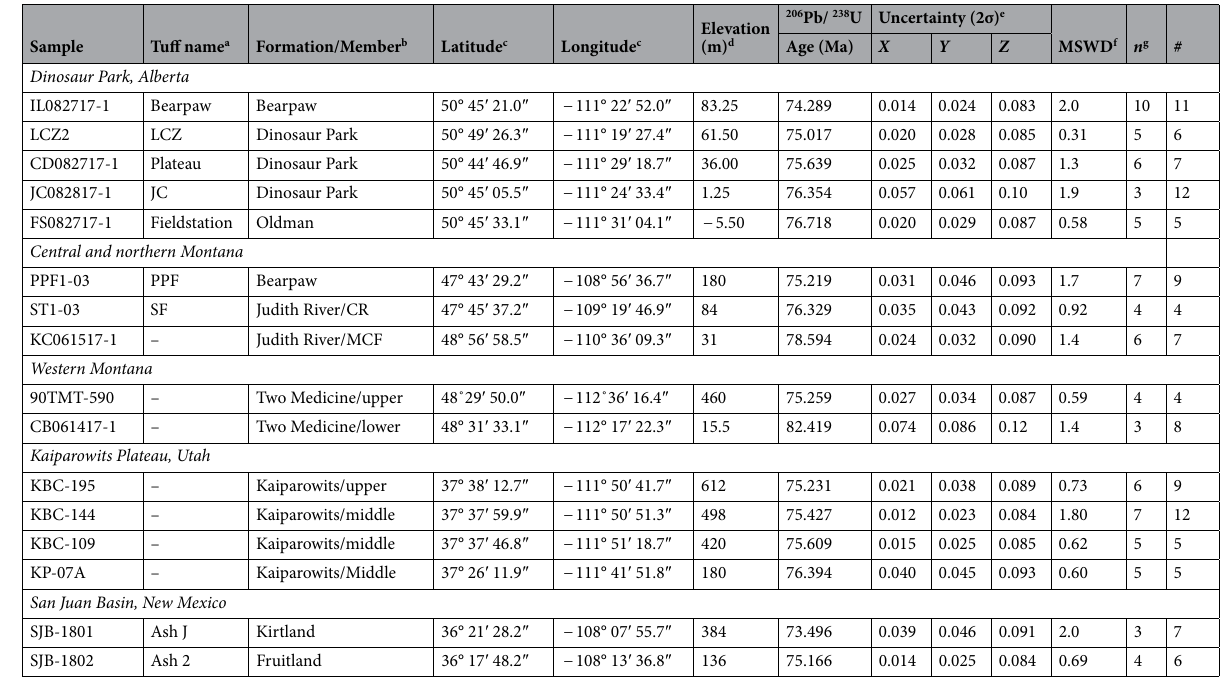
Table 1. Summary of calculated U–Pb ages and their uncertainties. a JC, Jackson Coulee; LCZ, Lethbridge Coal Zone; PPF, Power Plant Ferry; SF, Stafford Ferry. b CR, Coal Ridge Member; MCF, McClelland Ferry Member. c Latitude/Longitude relative to WGS 84 datum. For San Juan Basin samples they are estimated from Fassett 107 maps locations. d Stratigraphic elevation above the formation boundary, where measured. e X